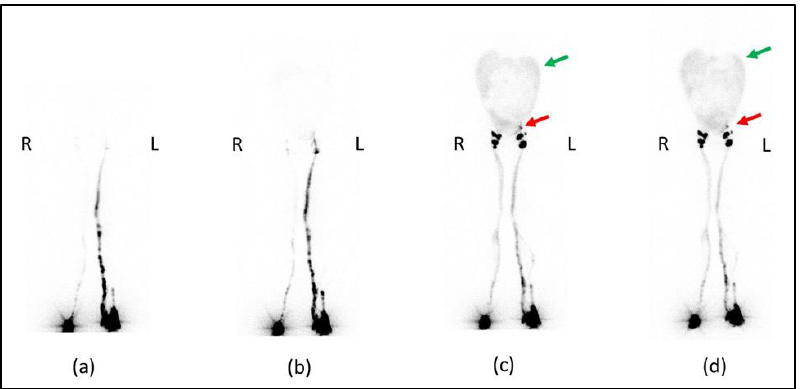
Figure 3. Anterior whole-body lymphoscintigraphy with 99mTc-labelled human serum albumin nanocolloids performed at the 30th minute ( a ) and at the 1st hour ( b ) after administration showed delayed and asymmetric lymphatic drainage of lower limbs. The anterior scans performed after a high-fat meal at the 2nd ( c ) and 3rd hours ( d ) showed bilateral inguinal lymph nodes, one focal spot of radiotracer uptake in the left iliac region (red arrows) and diffuse smooth abnormal abdominal radiotracer uptake (green arrows). R = right side; L = left side.